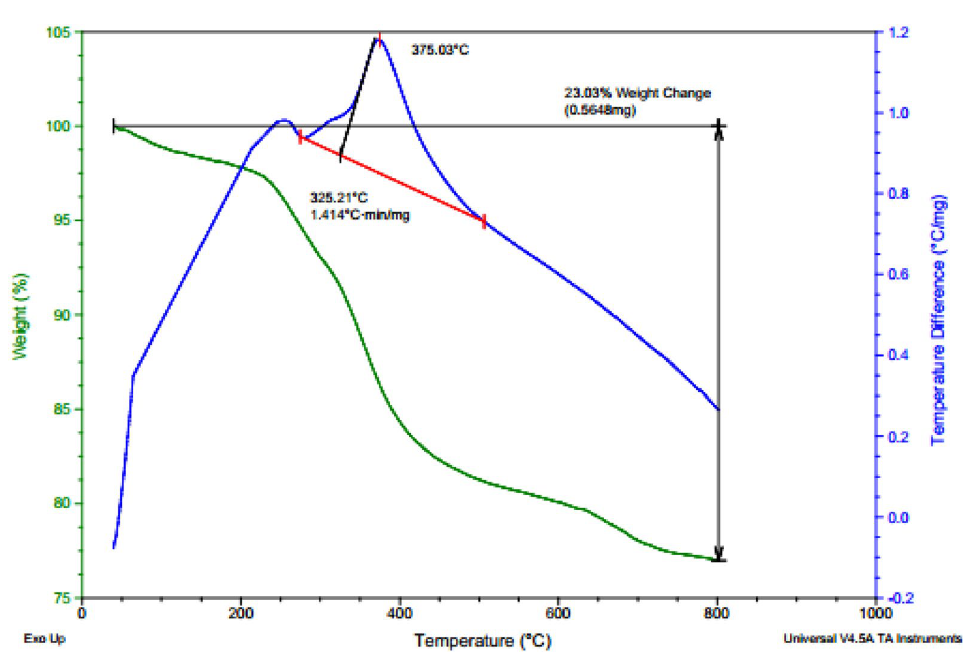
Figure 4. Thermal gravimetric analysis of the Fe 3 O 4 @Glycerol-Cu